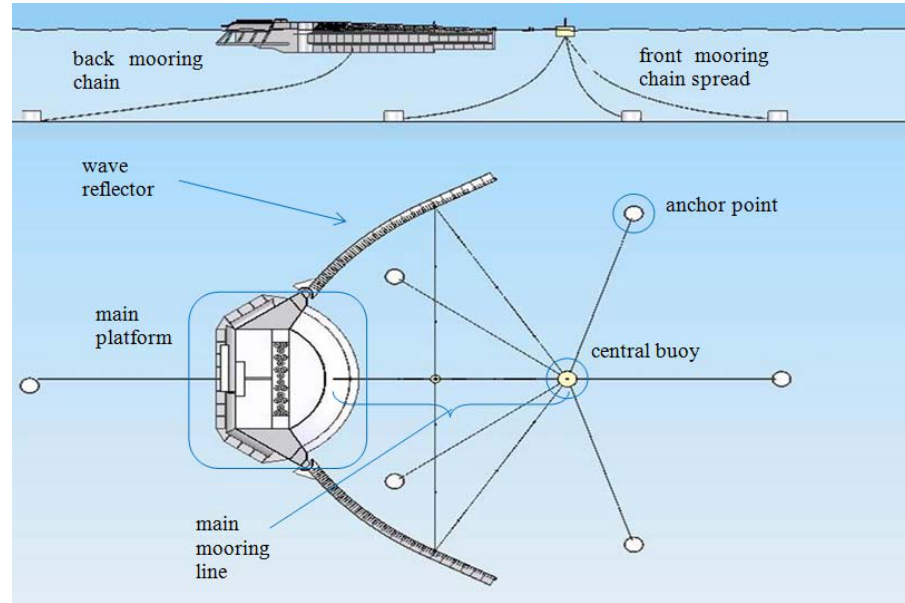
Figure 2. Conceptual mooring system of Wave